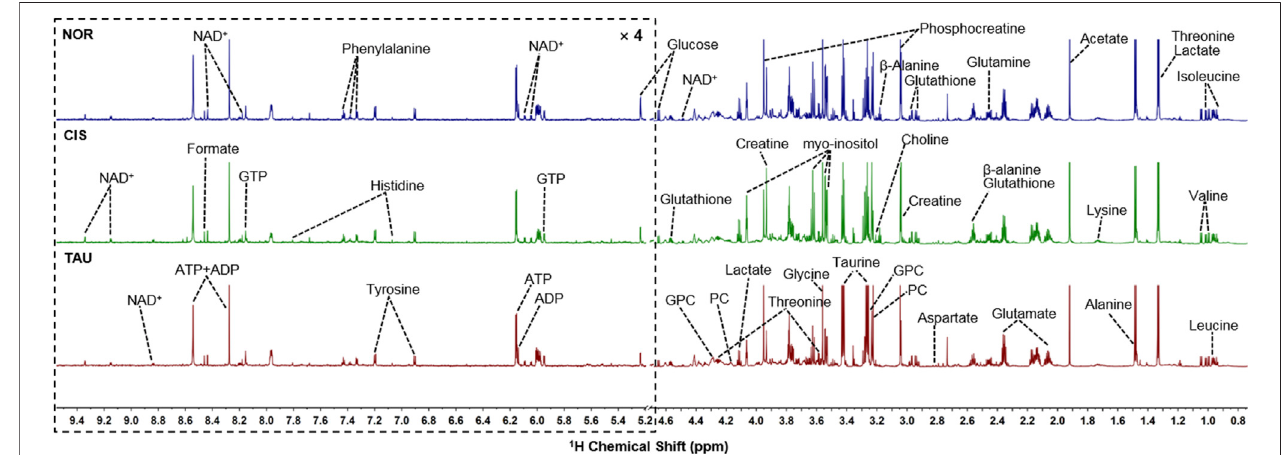
FIGURE4| Typical850 MHz 1 HNMRspectrarecordedonaqueousextractsderivedfromthethreegroupsofC2C12myoblasts.Verticalscalesarekeptconstant in all the 1 H spectra. Spectral regions of 0.8 – 4.6 ppm and 5.2 – 9.5 ppm are shown, and the water region of 4.6 – 5.2 ppm was removed. The region of 5.2 – 9.5 ppm has been magni fi ed 4 times compared to another region of 0.8 – 4.6 ppm for the purpose of clarity. Identi fi ed metabolites are shown in Table 1 . Abbreviations: PC, O-phosphocholine; GPC, sn-glycerol-3-phosphocholine; GTP, guanosine triphosphate; ATP, adenosine triphosphate; ADP, adenosine diphosphate; NAD + , nicotinamide adenine dinucleotide.